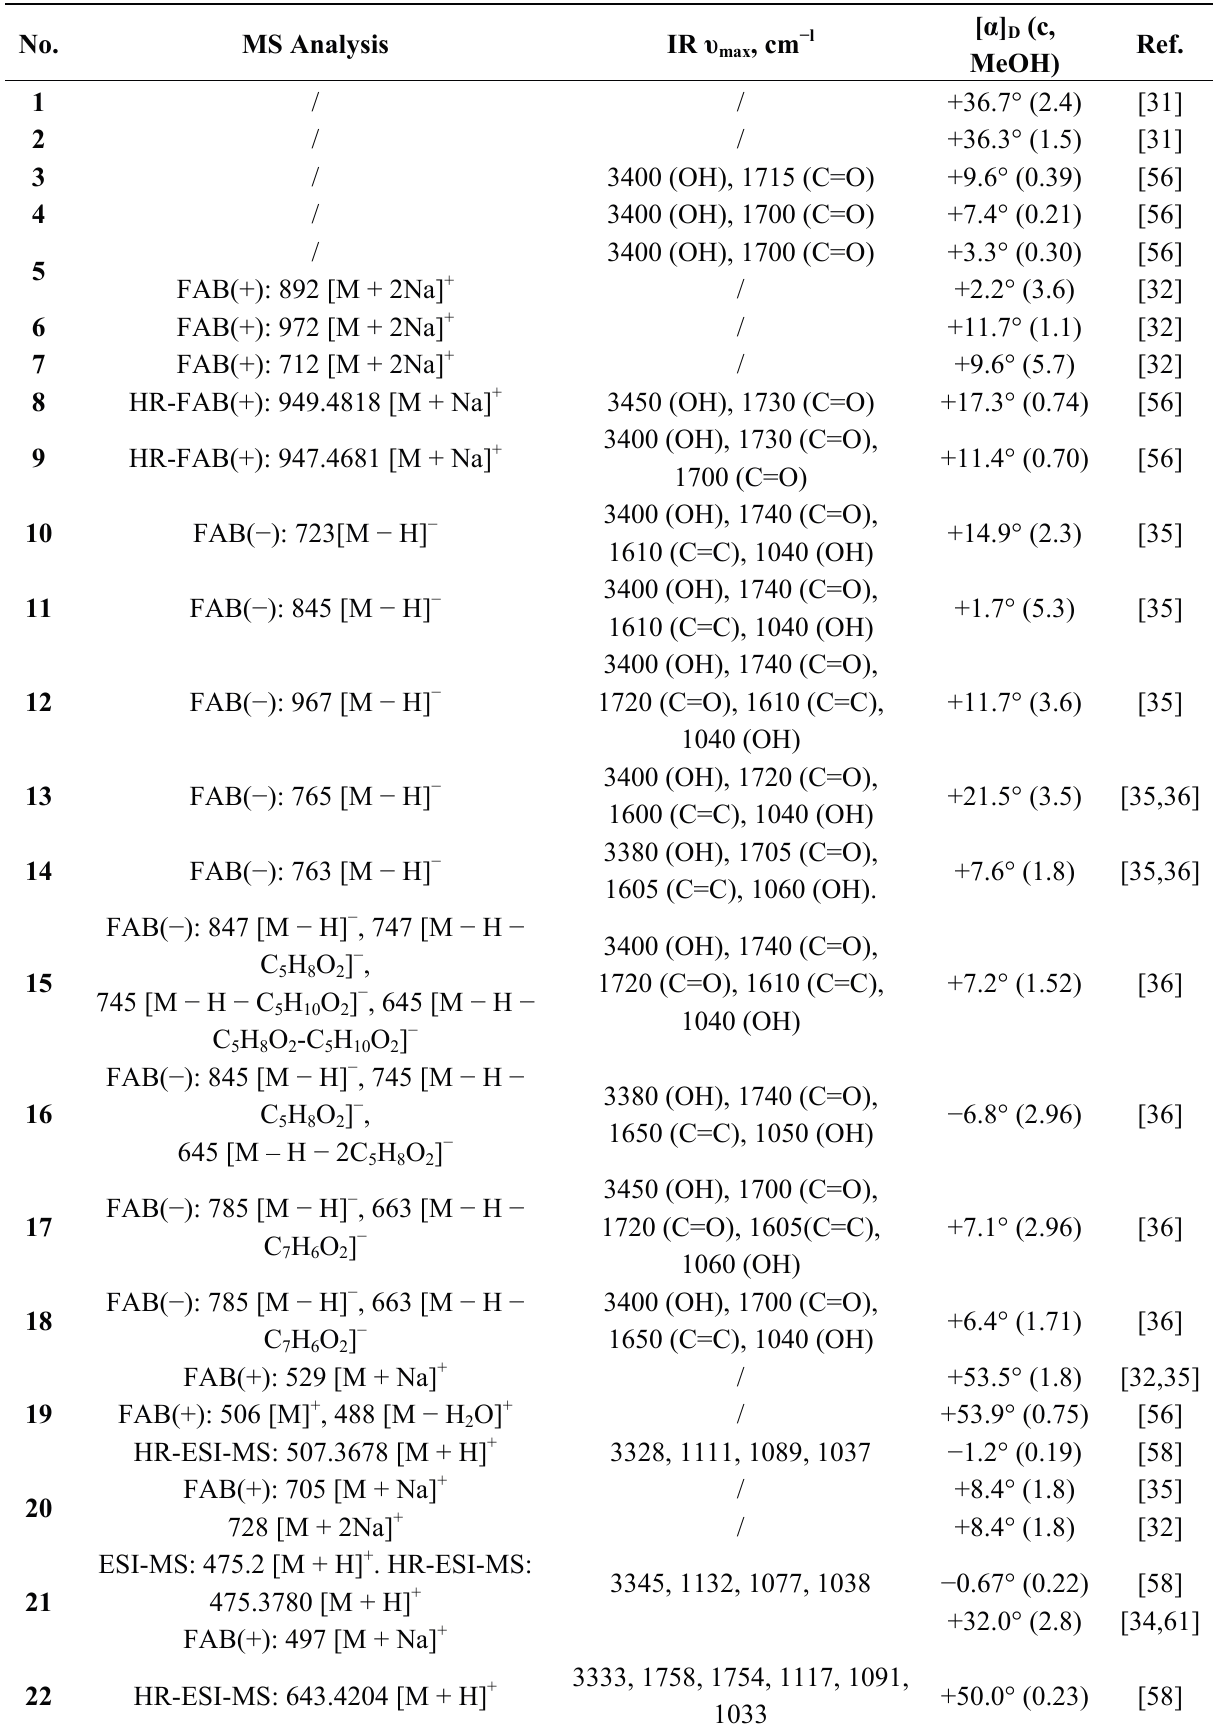
Table 4. Physico-chemical characterization of